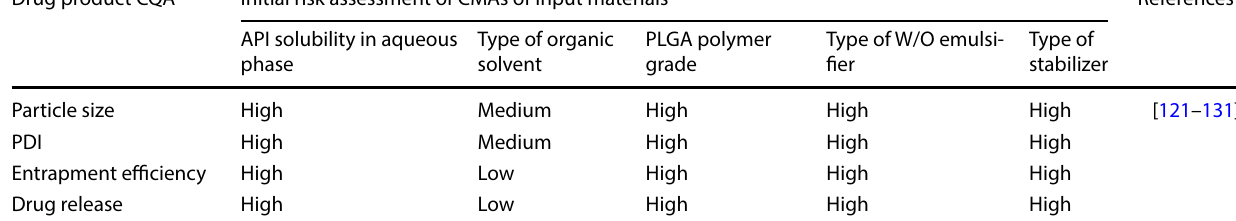
Table 3 Drug product CQA for Initial risk assessment of CMAs of input materials, formulation variables, and process variables Drug product